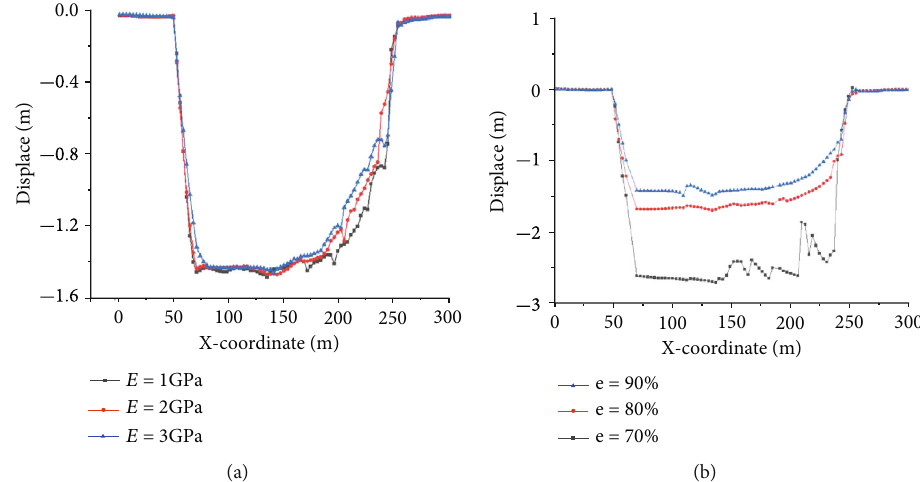
Figure 9: Long-term roof subsidence: (a) long-term roof subsidence for fi lling materials with di ff erent elastic moduli; (b) long-term roof subsidence for fi lling materials with di ff erent fi lling rates.